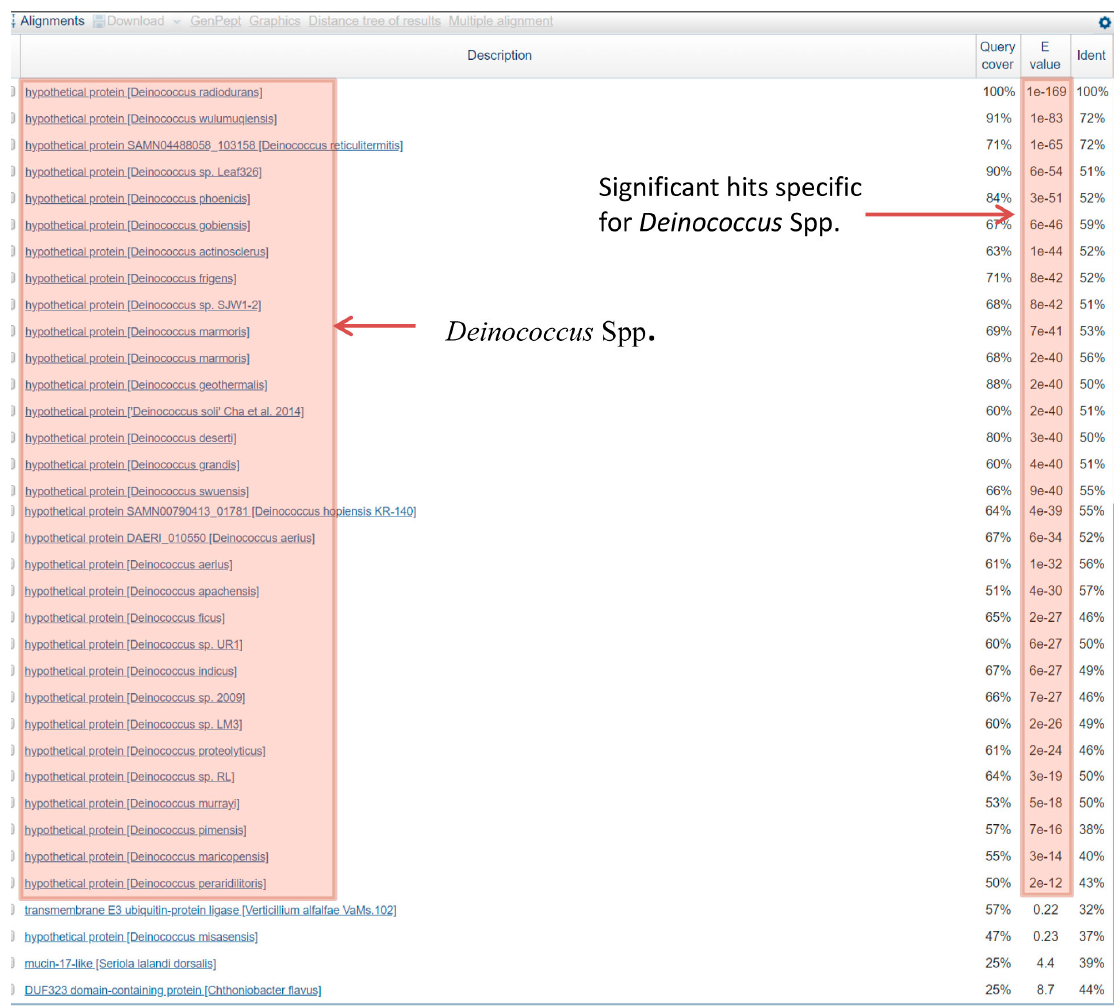
Figure A1. Blast Search Results Showing the Deinococcus specificity of the Protein dCSP-1. All BLASTp hits showing significant similarity to the dCSP-1 protein (accession number NP_295493) are for Deinococcus species.